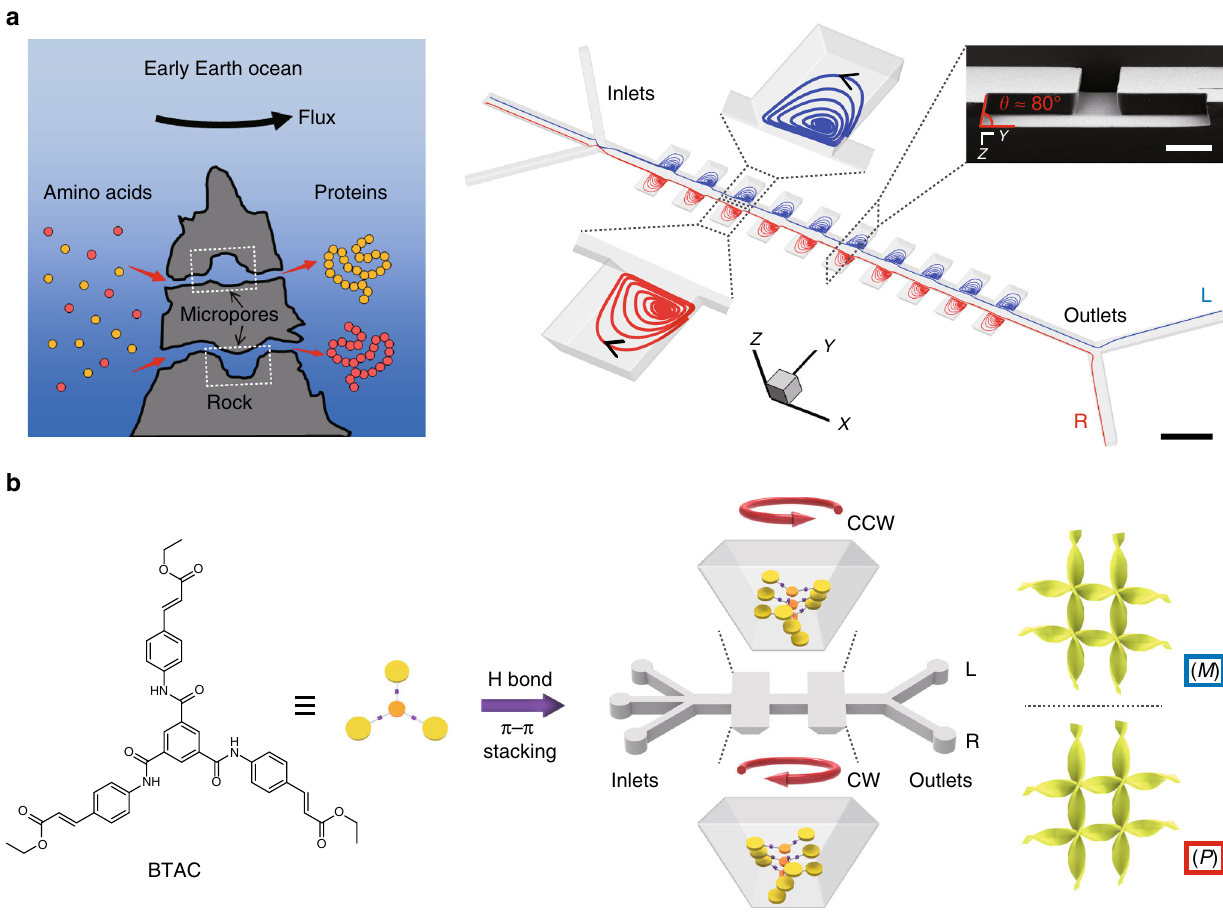
Fig. 1 Micro fl uidic design for self-assembly of BTAC building blocks in microvortices. a Schematic hypothesis of the emergence of supramolecular chirality after molecules pass through the submarine rock micropores (left), and the imitated design of micro fl uidic device consisting of ten pairs of inclined microchambers (right) to generate counter-rotating microvortices. The blue (red) streamlines refer to CCW (CW) microvortices in the left (right) microchambers. L (R) indicates the left (right) outlet along the fl ow direction. Scale bar, 500 μ m. The inset is SEM image of the cross-section of microchambers. Scale bar in the inset, 100 μ m. b Effect of the shear forces of enantiomorphic microvortices (CW and CCW rotating directions) on the mirror symmetry breaking process of achiral BTAC molecules in DMF/H 2 O mixtures leading to the formation of BTAC gels. M ( P ) chirality refers to left- handed (right-handed) helical